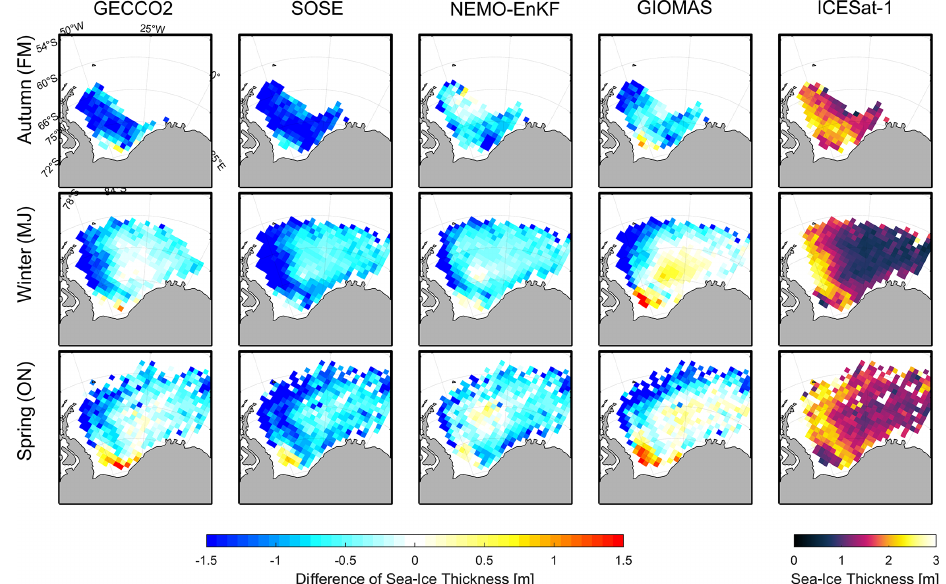
Figure 6. The differences of sea-ice thickness between GECCO2 (first column), SOSE (second column), NEMO-EnKF (third column), GIOMAS (fourth column) and ICESat-1 in Autumn-FM (first row), Winter-MJ (second row) and Spring-ON (third row).The contours in last column represent the autumn sea-ice thickness of